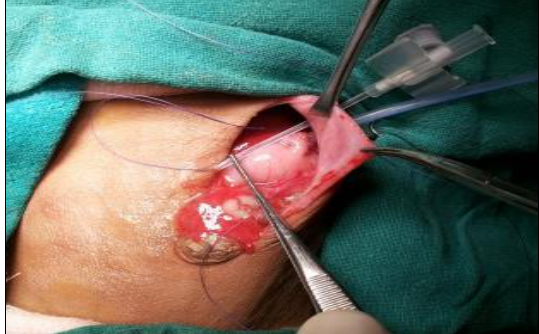
Figure 2: A cannula inserted to bring needle-free ends of purse-string sutures separately.